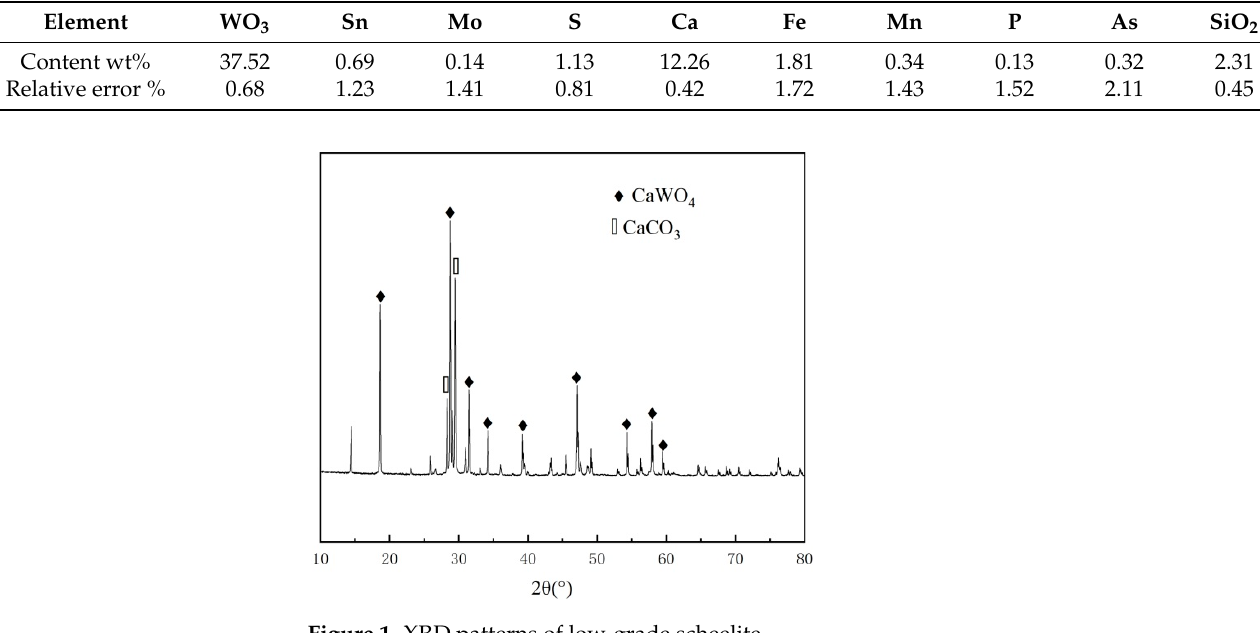
Table 1. Main components of low-grade scheelite.